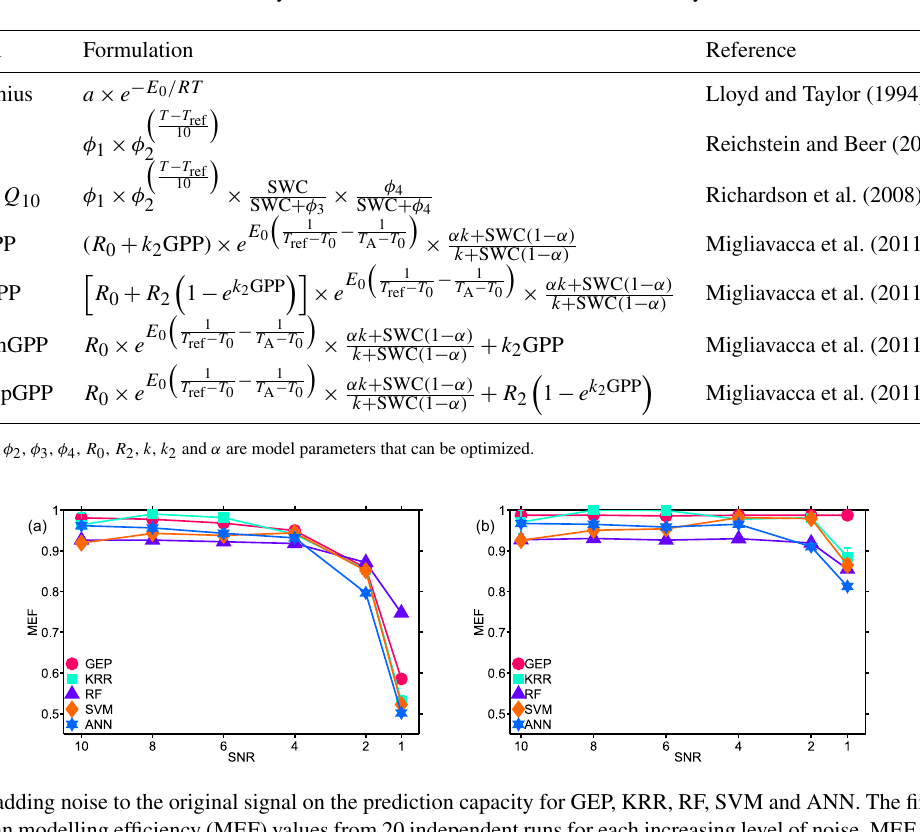
Table 2. Respiration model formulations commonly used in the environmental science community.